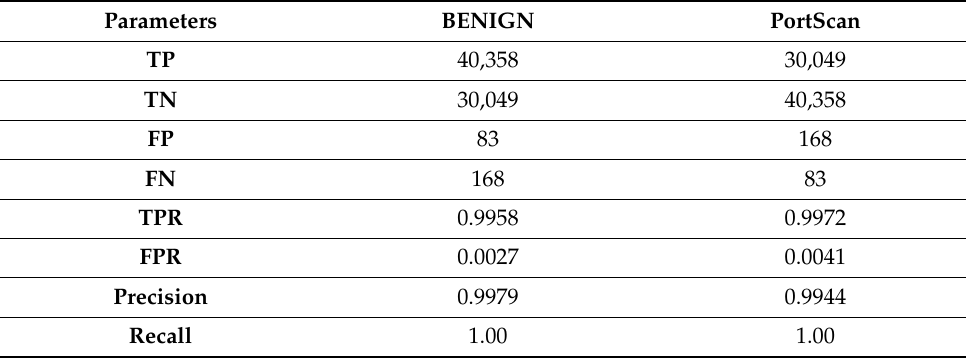
Table 10. Statistical report of Friday afternoon PortScan test